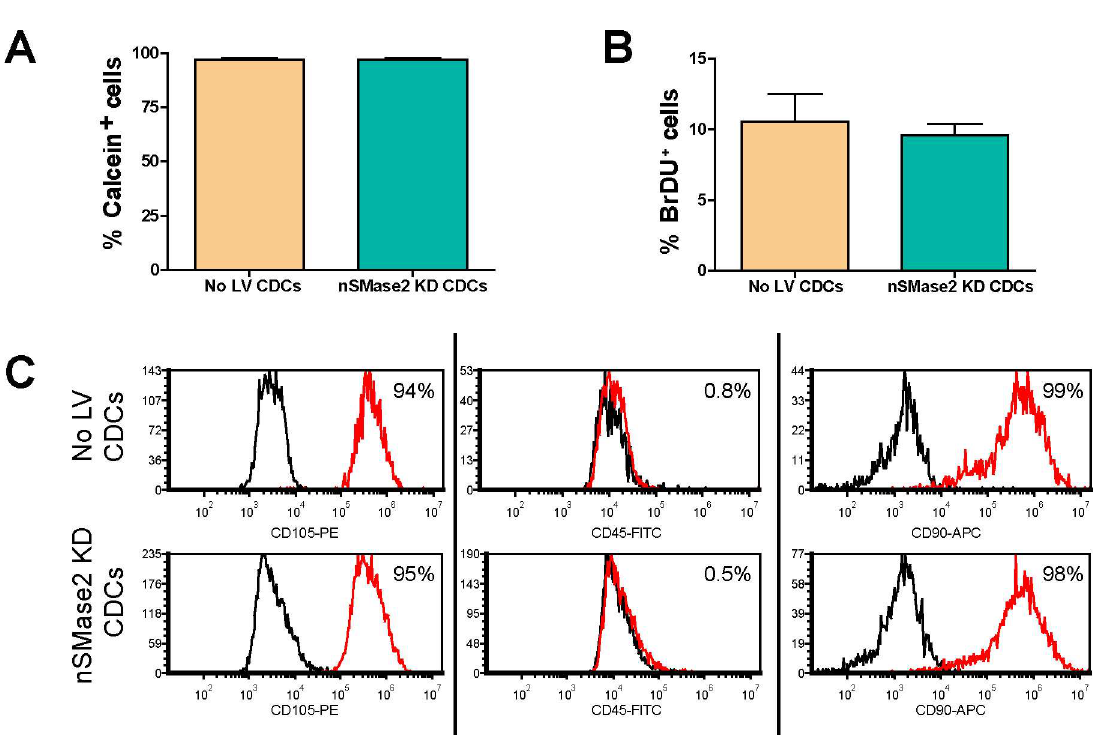
Fig 5. nSMase2 lentiviral integration does not change CDC survival, proliferation or gene expression. Nontransduced CDCs and nSMase2 shRNAi lentiviral infected CDCs show no significant difference in (A) survival assessed with calcien staining, (B) proliferationassessed with BrDU+ pulse or (C) surface marker expression (CD90, CD105 and CD45 plotted in red and their respective isotype controls plotted in